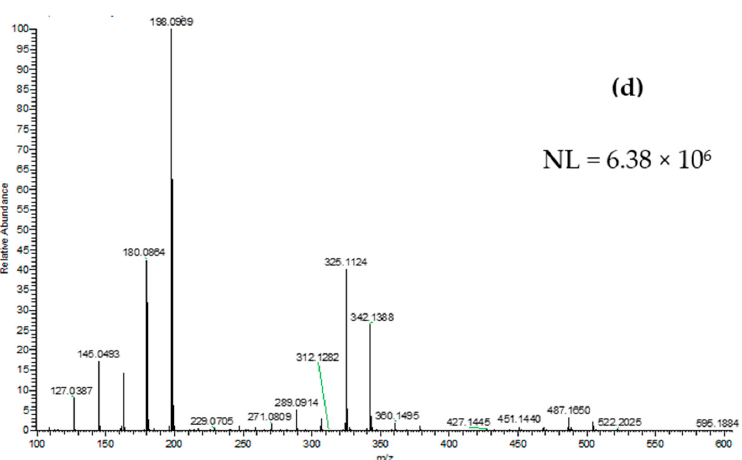
Figure 1. Representative DART-HRMS positive ion spectra acquired for the sample extracts of chestnut honeys from Italy ( a ), chestnut honeys from Portugal ( b ), acacia honeys from Italy ( c ) and acacia honeys from China ( d ). NL: Normalization level.